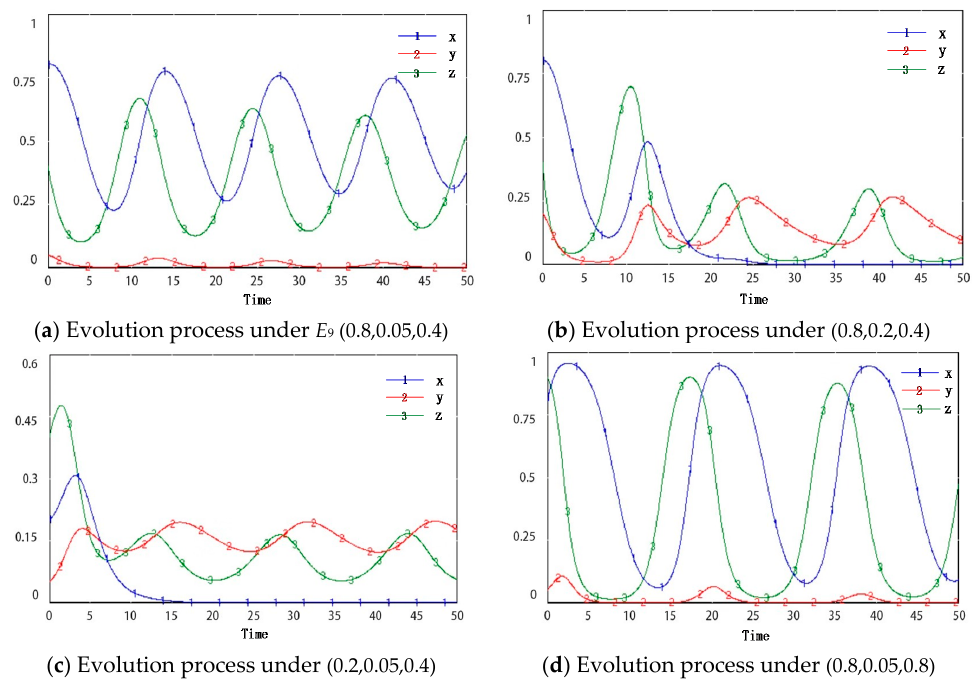
Figure 6. Evolutionary game process of one population’s mutation when initial state is mixed strategies.